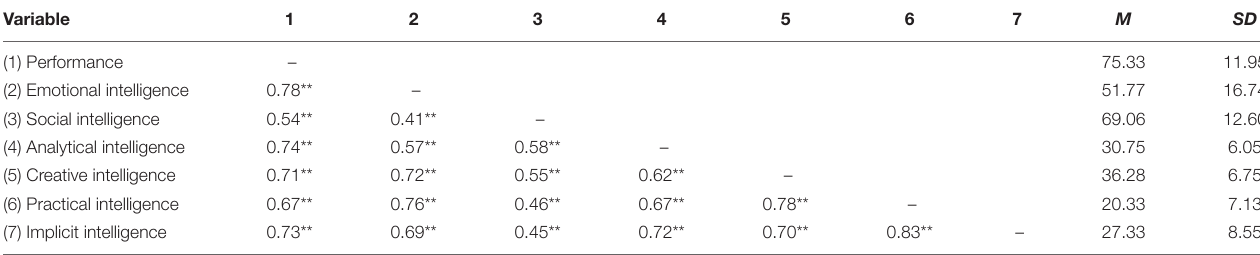
TABLE 1 | Correlations, means, and standard deviations for all variables.